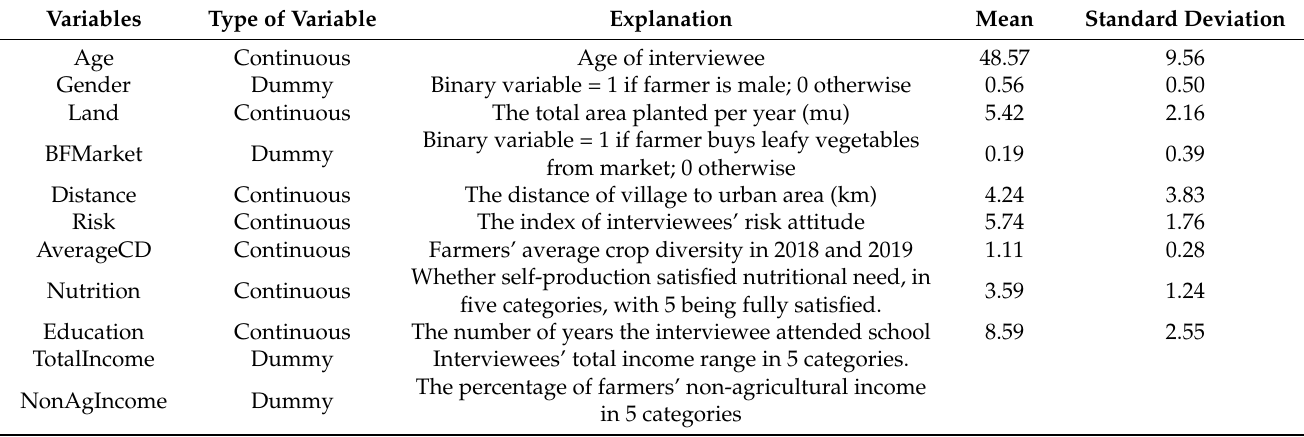
Table 1. Different variables that included in the questionnaire and subsequent modeling process. Total income and non-agricultural income were coded as dummy variables. Raw data for TotalIncome and NonAgIncome is shown in Supplemental Table